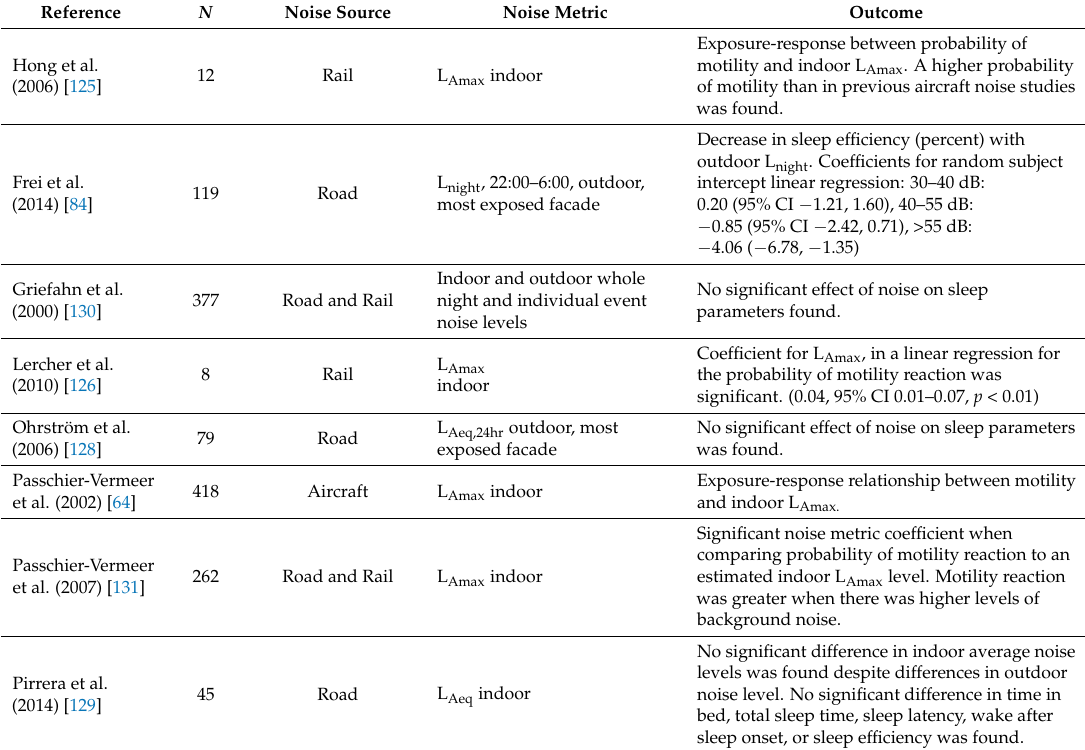
Table 11. Characteristics of studies that evaluated sleep based on measures of